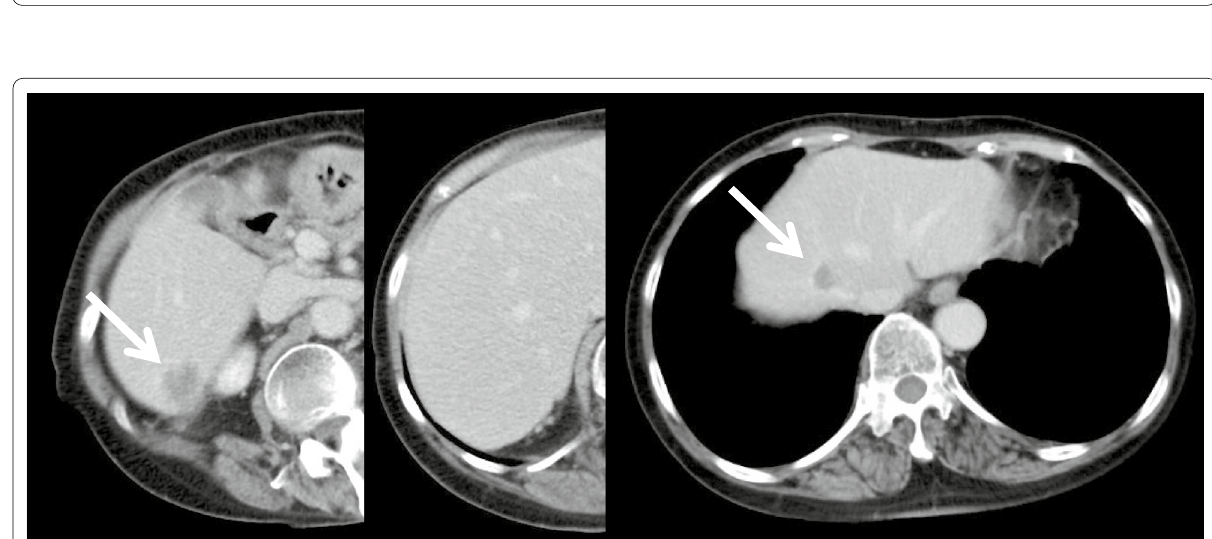
Fig. 4 Abdominal CT scan at 3 months postoperatively showing marked increase in multiple liver metastases (white arrow). CT computed tomography